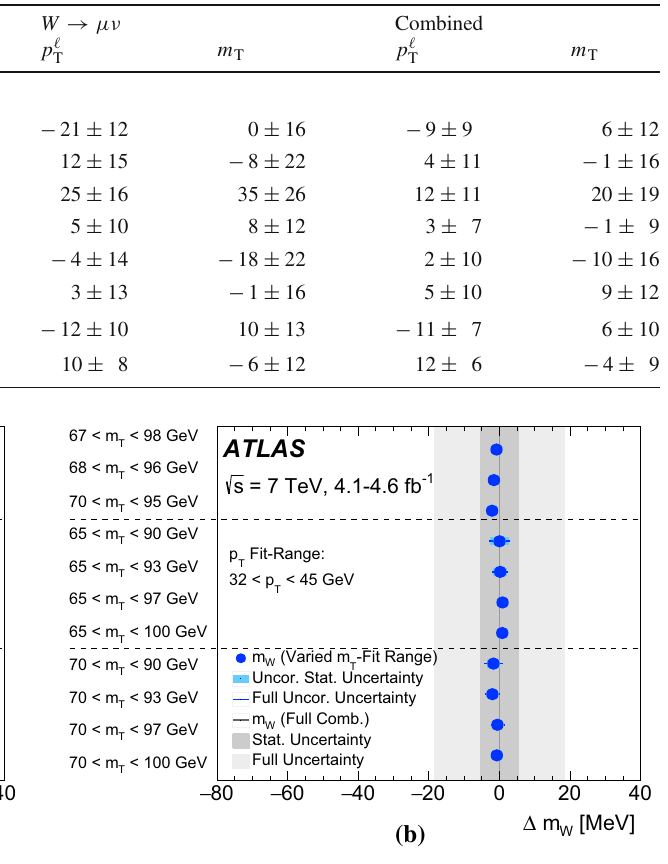
Table 12 Summary of consistency tests for the determination of m W in several additional measurement categories. The (cid:6) m W values cor- respond to the difference between the result for each category and the inclusiveresultforthecorrespondingobservable( p (cid:7)